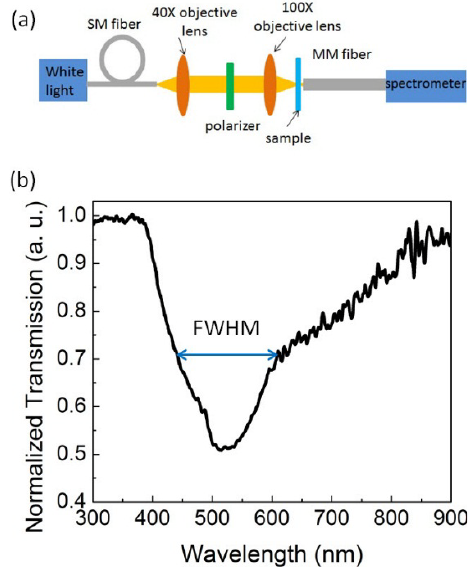
Figure 3. ( a ) Experimental setup of the transmission measurement; and ( b ) the experimentally measured transmission spectrum of the ITO grating coated with SOG. SM, single